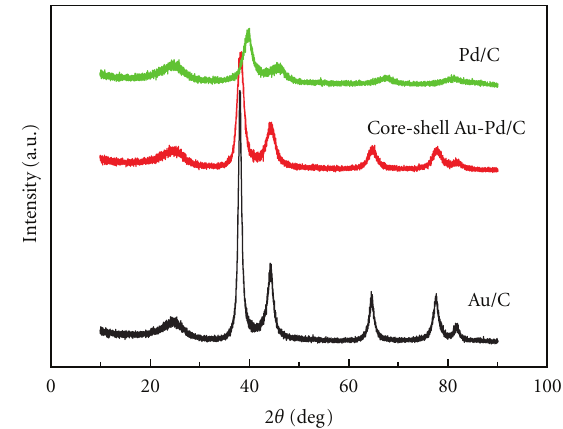
Figure 2: XRD patterns of Au/C, core-shell Au-Pd/C, and Pd/C.